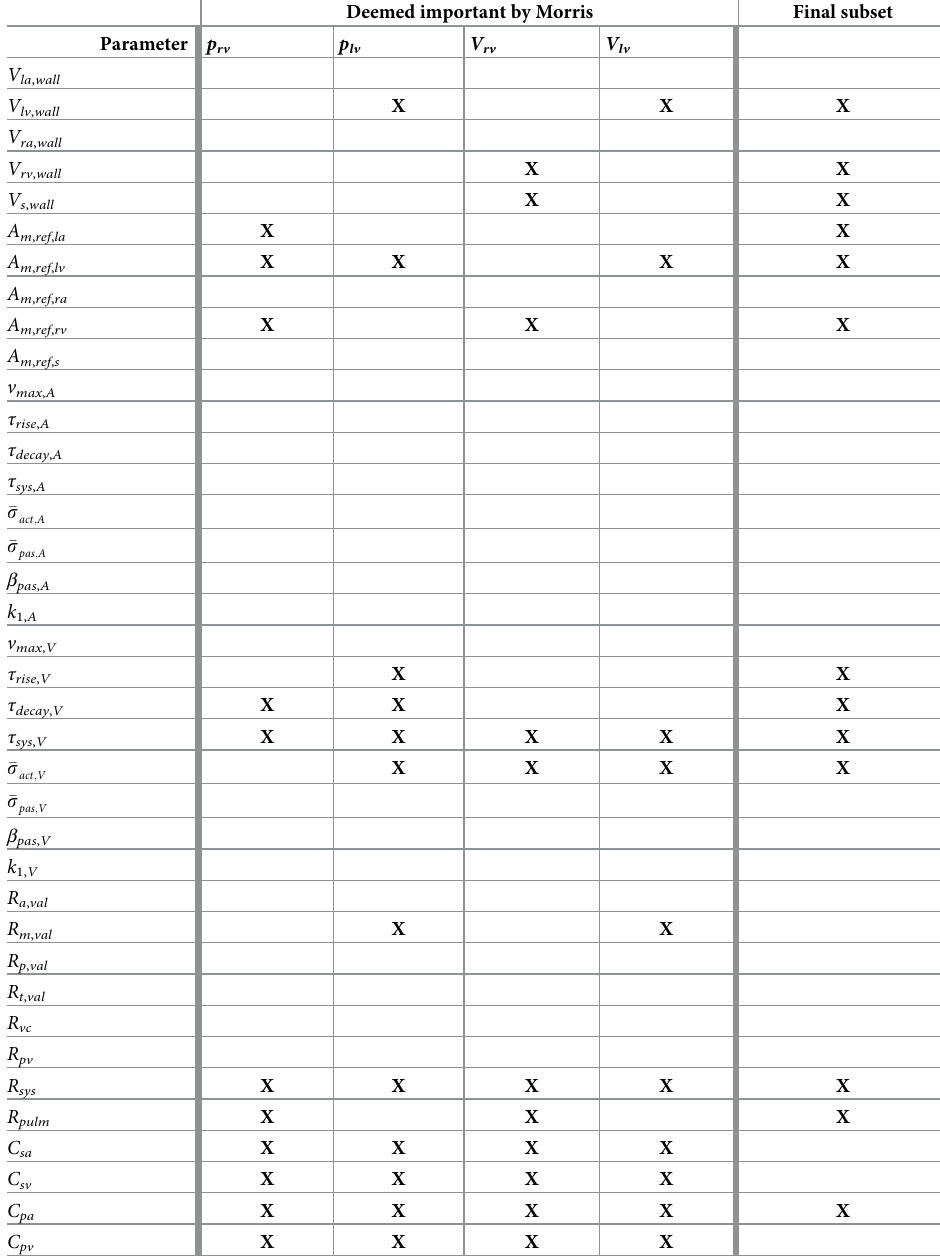
Table 2. Parameters deemed influential by Morris screening and included in the final subset after using a local sensitivity based practical identifiability analysis. Deemed important by